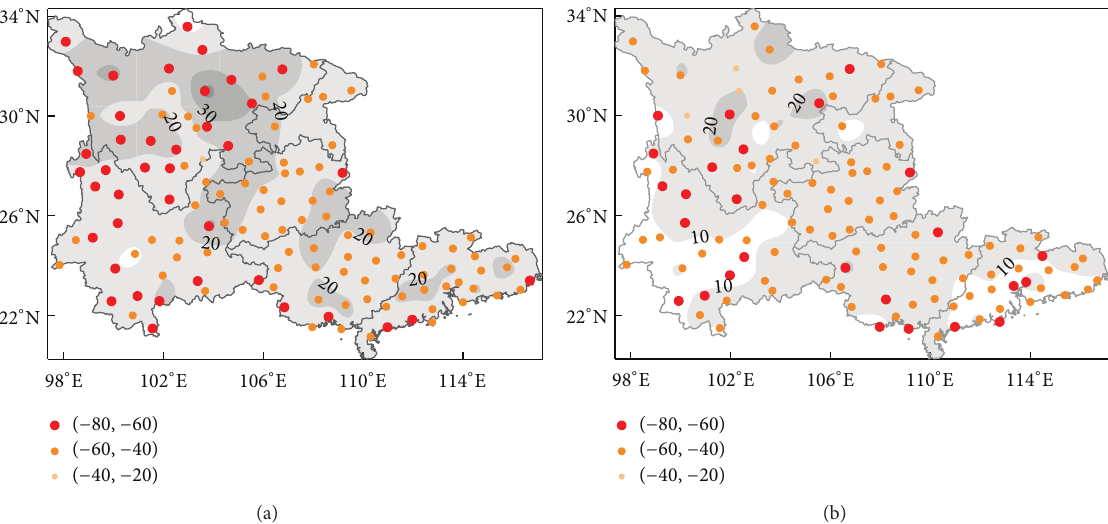
Figure 9: Weighting precipitation deficit (colored dot, unit: %) and the percentage of droughts accounted for by each deficit (blank map, unit: %). The timescale is 2 months (a) and 3 months